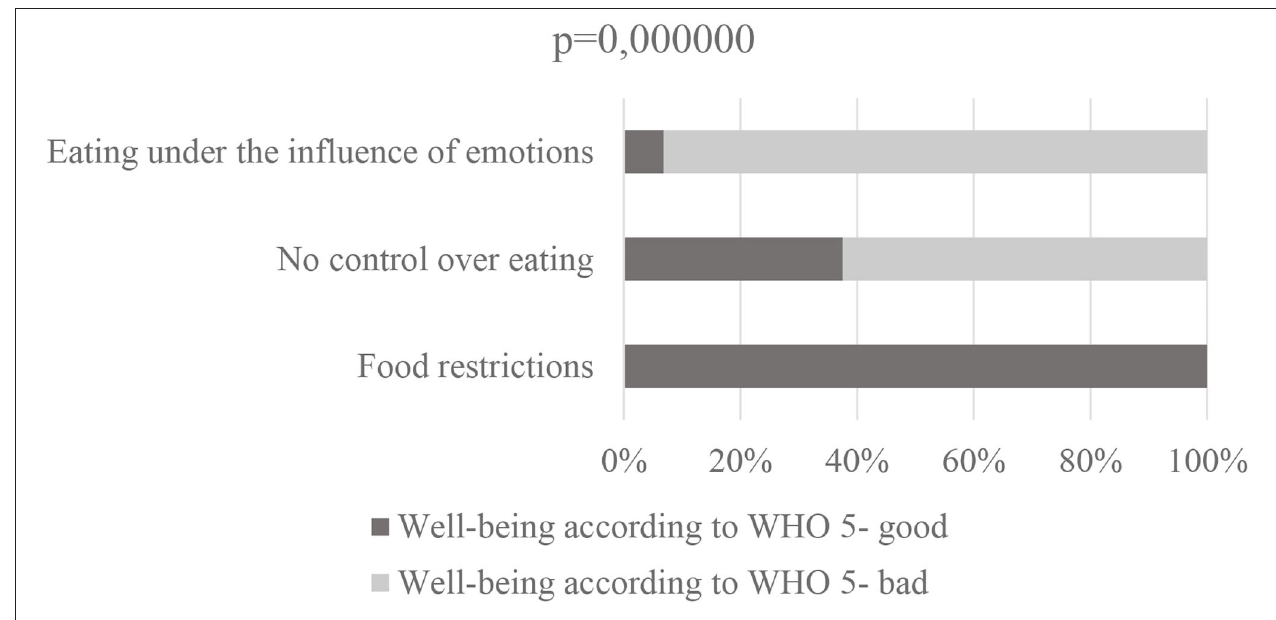
FIGURE 3 | TFEQ 13, and well-being according to WHO-5 n = 225.